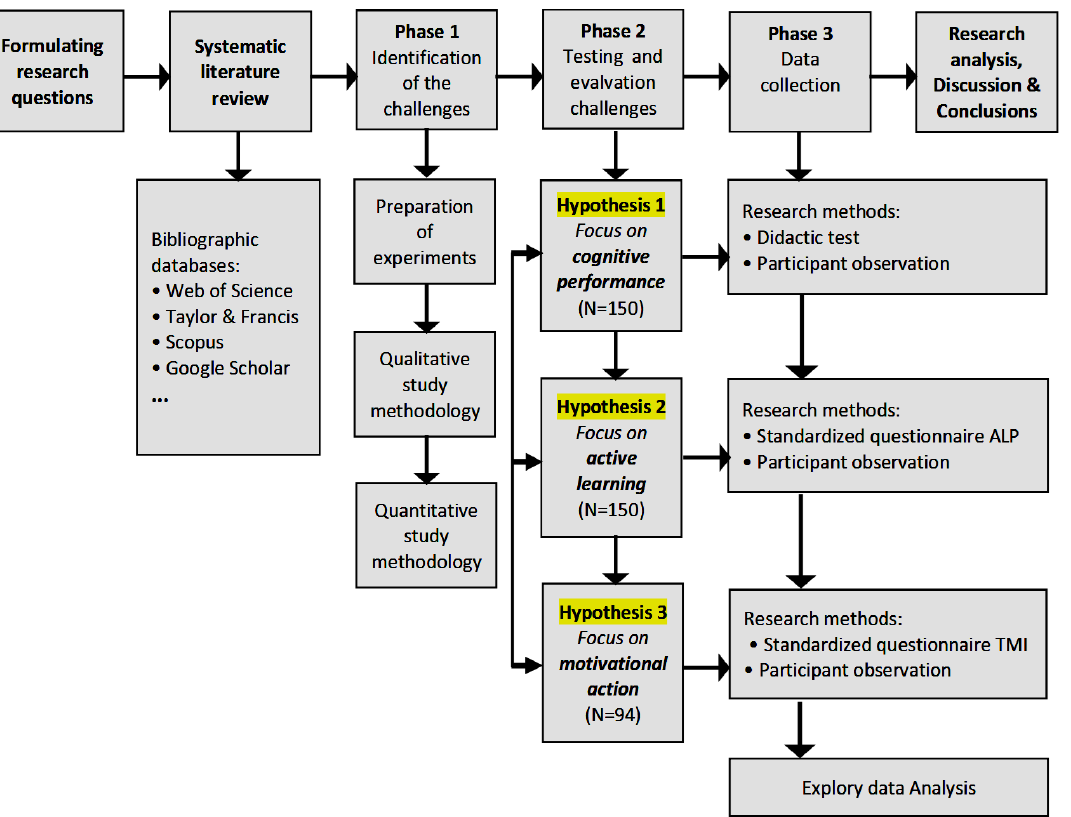
Figure 1. Methods and materials for the three phases of the research study